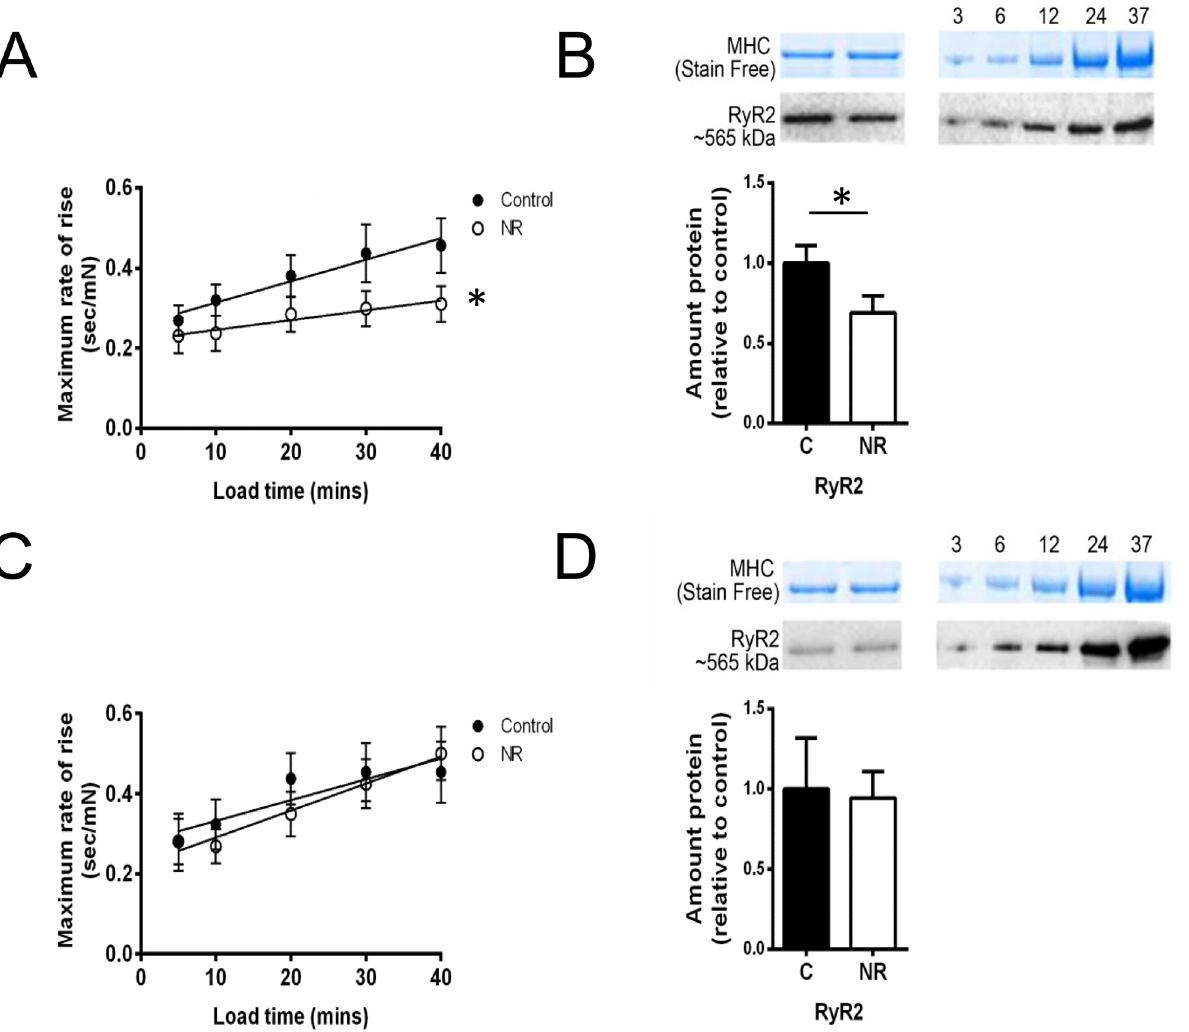
Fig 5. Sarcoplasmic reticulum caffeine-induced Ca 2+ release properties. Maximum caffeine-induced Ca 2+ release rate and relative RyR2 protein content with associated stardard curves for both male (A-B) and female (C-D) offspring. Linear regression of release rates indicated Male NR bundles had a significant decrease in maximum release rate. ( F (1,6) = 13.74, * P < 0.05). Relative amount of RyR2 protein was significantly lower in male NR samples compared with controls (C n= 10, NR n=8; Student ’ s t-test, * P < 0.05). No differences were observed between treatments in female offspring. Values above standard curves indicate amount ( μ g) wet muscle